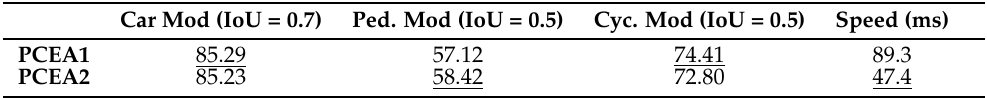
Table 6. Performance of PCEA after different stages. PCEA1 and PCEA2 mean adding the PCEA module after SA1 and SA2 separately. The AP value is calculated with 40 recall positions on moderate subsets. The best results are